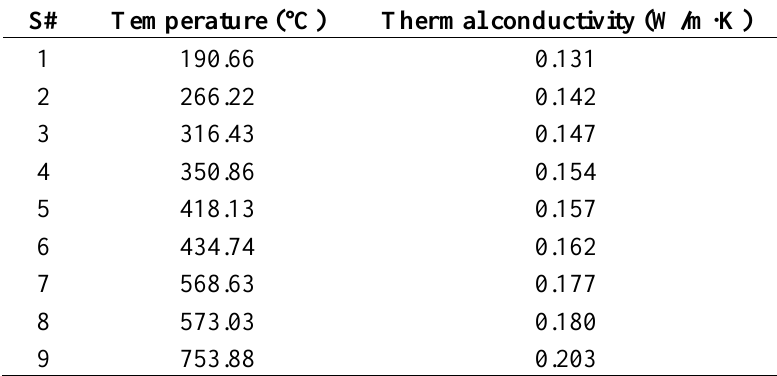
Table 3. Thermal conductivity of perlite concrete with temperature. Data from